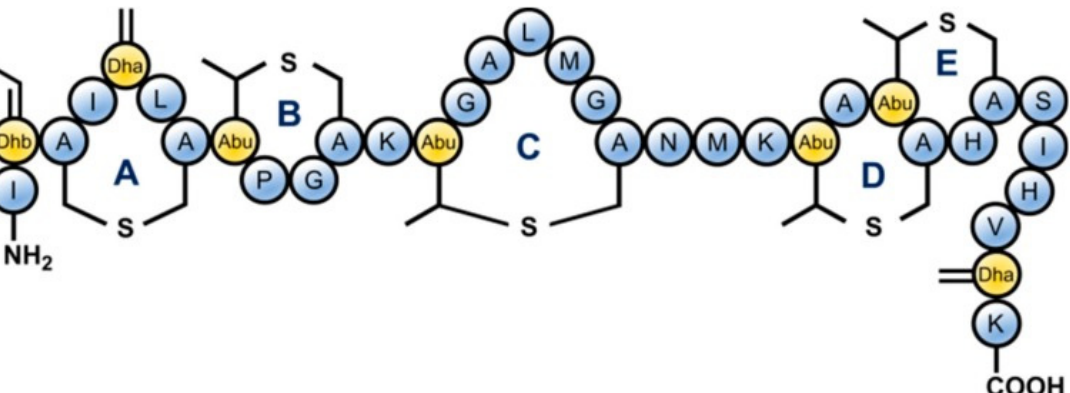
Figure 1. Structure of Nisin which is a lantibiotic AMP due to the presence of uncommon lanthionine rings in the structure and also the unsaturated amino acids introduced by posttranslational modifications: Dhb = dehydrobutyrine, Dha = de- hydroalanine and Abu = aminobutyric acid [22].